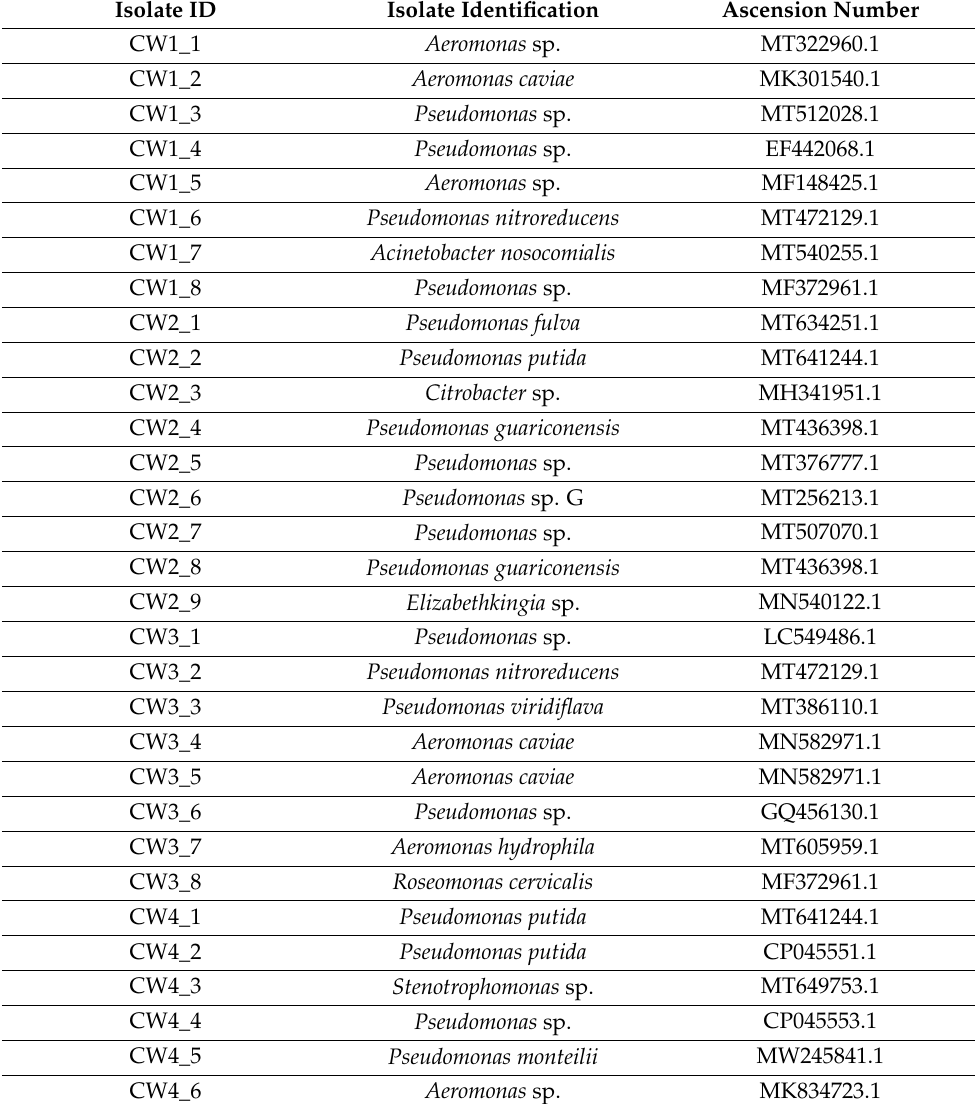
Table 4. 16S rRNA bacterial identification sequencing results from ESBL isolates for all raw greywater treatment systems with corresponding ascension numbers. The ID is based on the system (CW1–CW4) and the isolate running